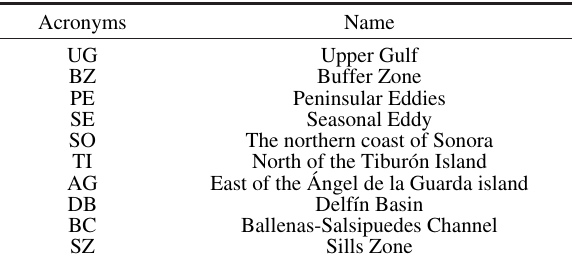
Table 1. – Areas of the northern Gulf of California (Santiago-García et al.